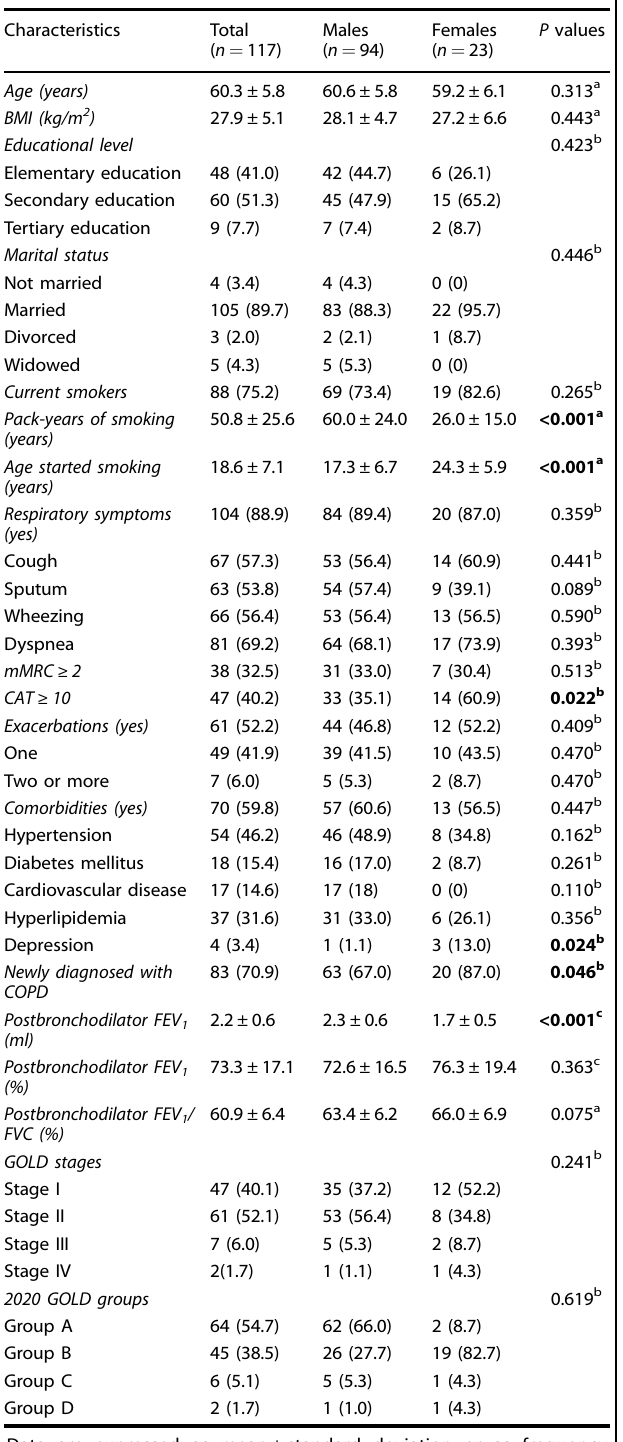
Table 1. Demographic, clinical, and spirometric characteristics of chronic obstructive pulmonary disease (COPD) patients ( N = 117) and gender-associated